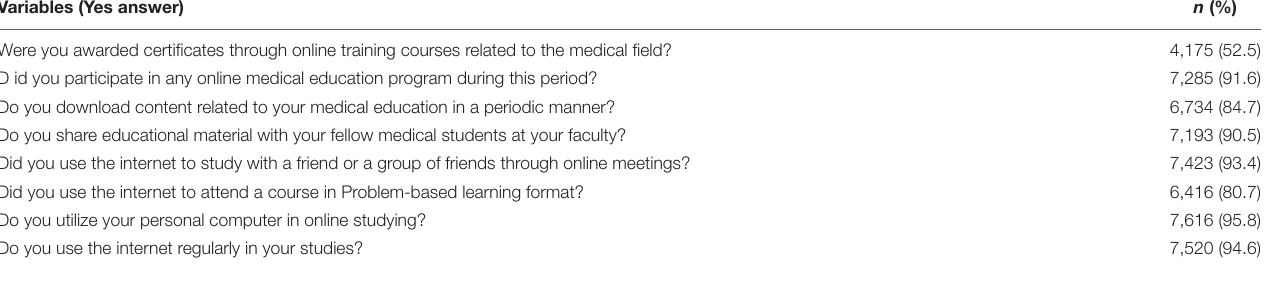
TABLE 7 | Medical students’ practice evaluation of e-learning.